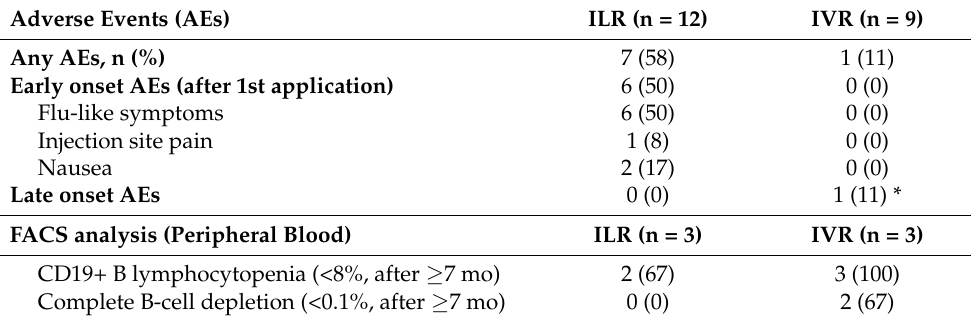
Table 2. Safety data for the ILR and IVR cohorts. Over half of the patients with ILR experienced minor symptoms after their first injection without further AEs in the course of therapy. In the IVR cohort, no early onset AEs were reported. One patient (*) developed pneumonia 1.4 months after the sixth cycle of IVR. While the FACS analysis 7 months or more post therapy revealed reduced B-cell counts in 5 of 6 the available patients, only IVR-treated patients showed persistent full B-cell depletion (<0.1%) after such a long